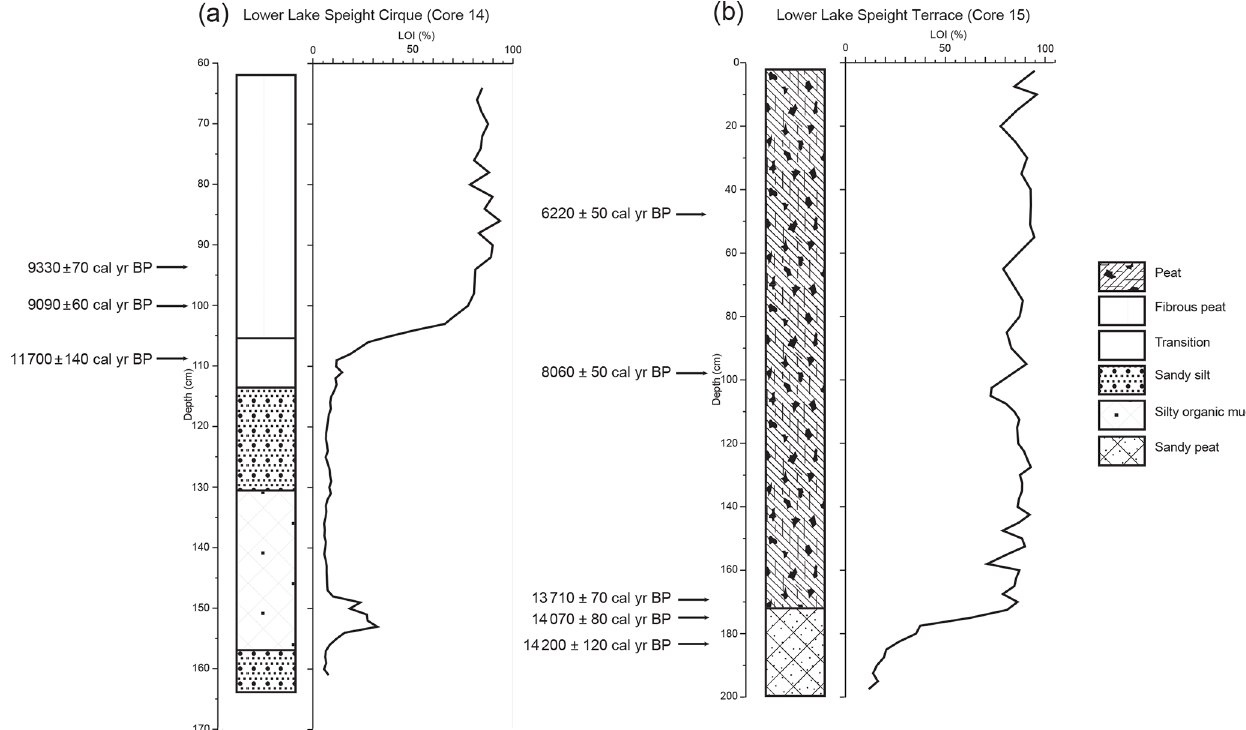
Figure 6. Schematic of sediment cores taken from lower Lake Speight cirque and terrace. Radiocarbon dates given as calibrated ages. Loss on ignition (LOI; %) curve shown alongside